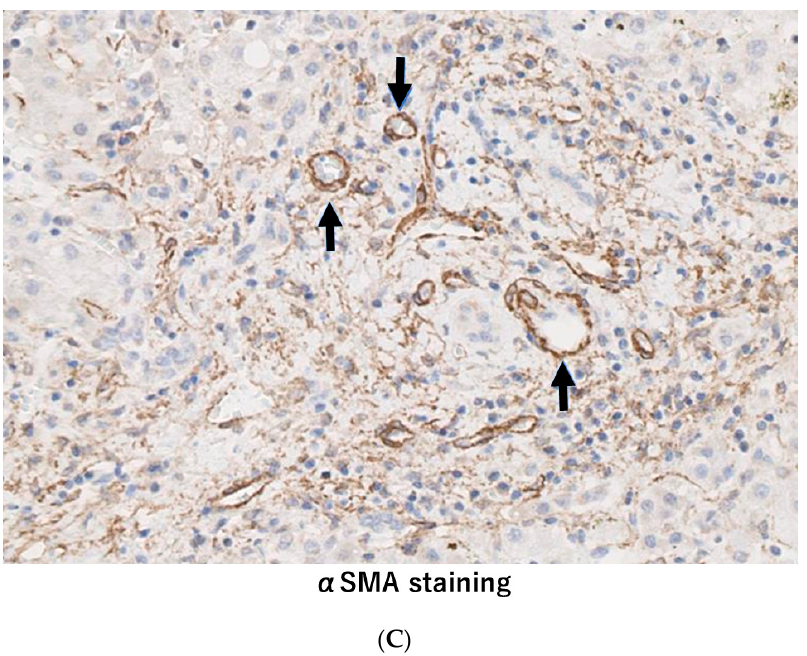
Figure 4. Pathology of resected liver (Case 3) at 4.0 months after stereotactic body radiotherapy (SBRT). ( A ) Silver impregnation stain. A, portal atrophy; B and C, portal vein disappearance and increased collagen fiber. Close to HCC nodule, hepatic tissue (hepatocyte and endothelium) fell off and so the portal tract (blue arrow) came close, and hepatic arteries (black arrows) subsequently increase. Background liver tissue fragment of A area (right; enlarged figure) showed hepatic arteries (black arrows) lined up inside the portal vein tract. ( B ) ( a ): Hematoxylin and eosin staining, ( b ): silver impregnation stain, ( c ): CD34, ( d ): CD31. ( C ) α Smooth Muscle Actin (SMA) immuno-histochemical staining. In portal tracts a little outside HCC nodule, portal vein disappeared and arteriole (positive at α Smooth Muscle Actin (SMA), arrows) increased. Close to HCC nodule, cluster of dif- ferentiation (CD)34, CD31 showed endothelium degeneration, and some disappeared. Hepatocyte was also lost, and then dilated space (Star mark) appeared.